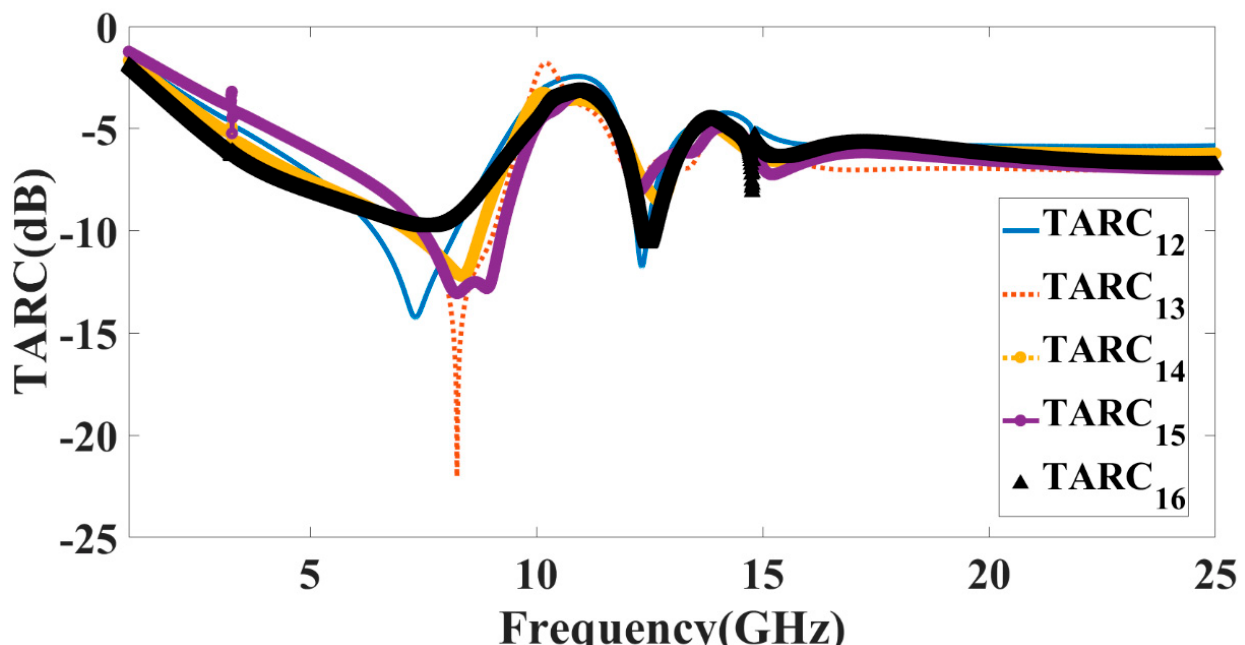
Figure 15. Calculated values of the TARC for antenna Design 5.